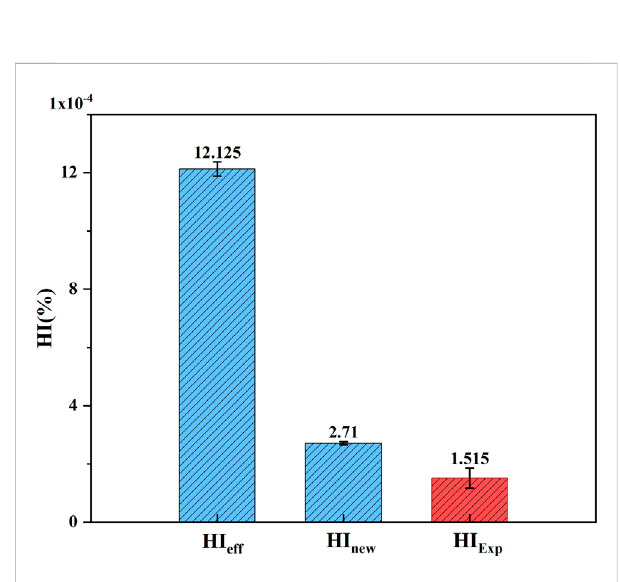
FIGURE 12 Comparison of hemolysis estimates and experimental values in the axial blood